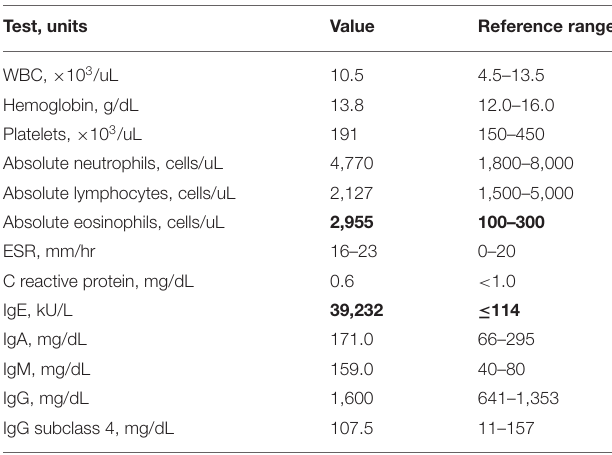
TABLE 1 | Laboratory